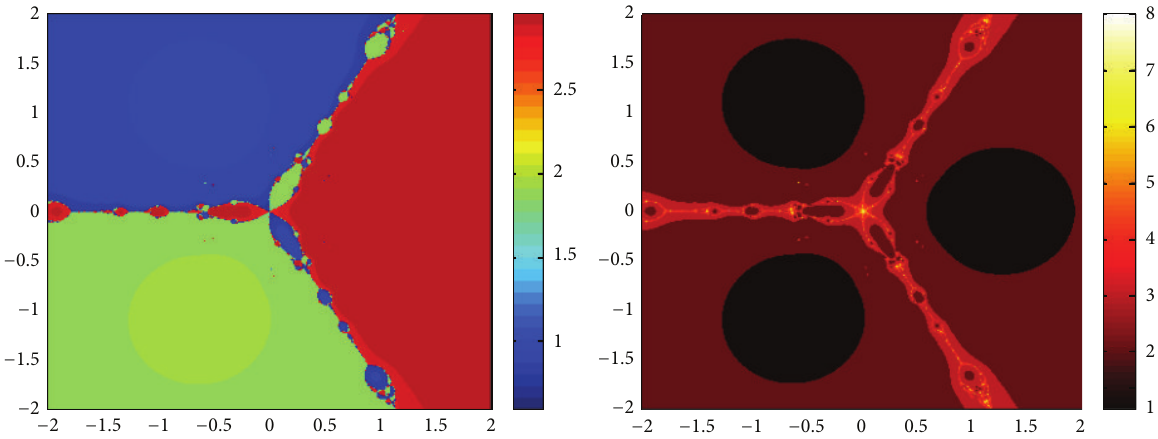
Figure 2: Basins of attraction of method (9) for 𝑝 3 (𝑥)